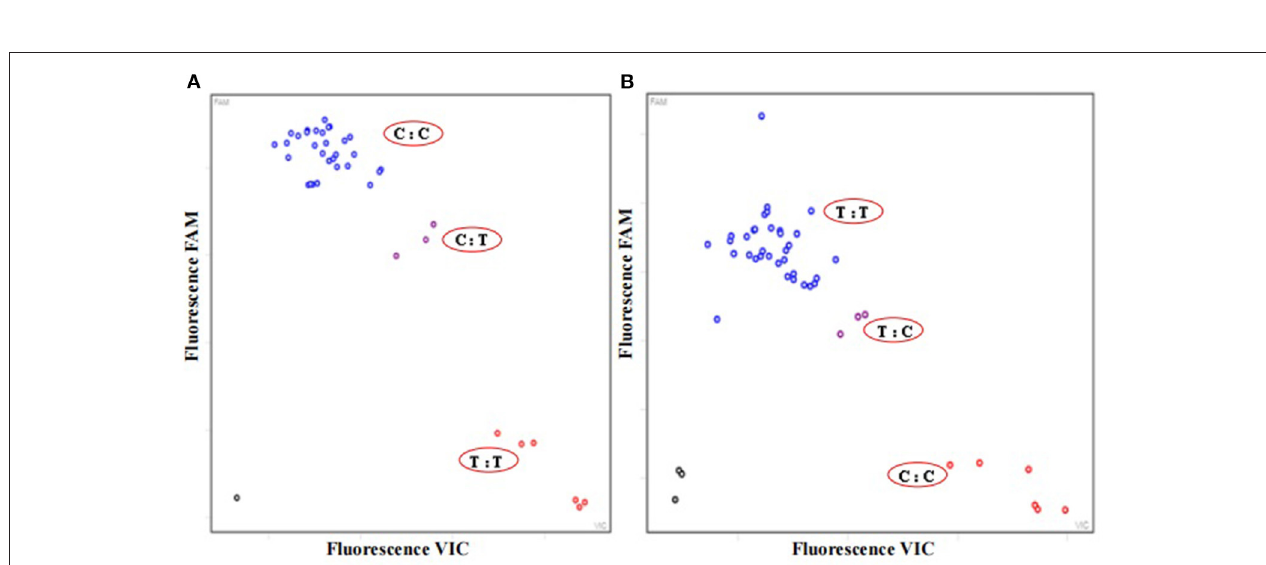
FIGURE 3 | Results of KASP assay for SNP 1 (A) with the primer group PAN_SNP1 and SNP 2 (B) with PAN_SNP1 for 12 batches of Qipi pill. Three replicates were set for each sample. The horizontal and vertical axes show the fluorescence signal of bases at different SNP sites. The blue and red circles represent the fluorescence signal of P. ginseng and P. quinquefolius respectively, and the purple signal represent the simultaneous appearance of P. ginseng and P. quinquefolius . The black circles on the bottom left are no-template control. Negative